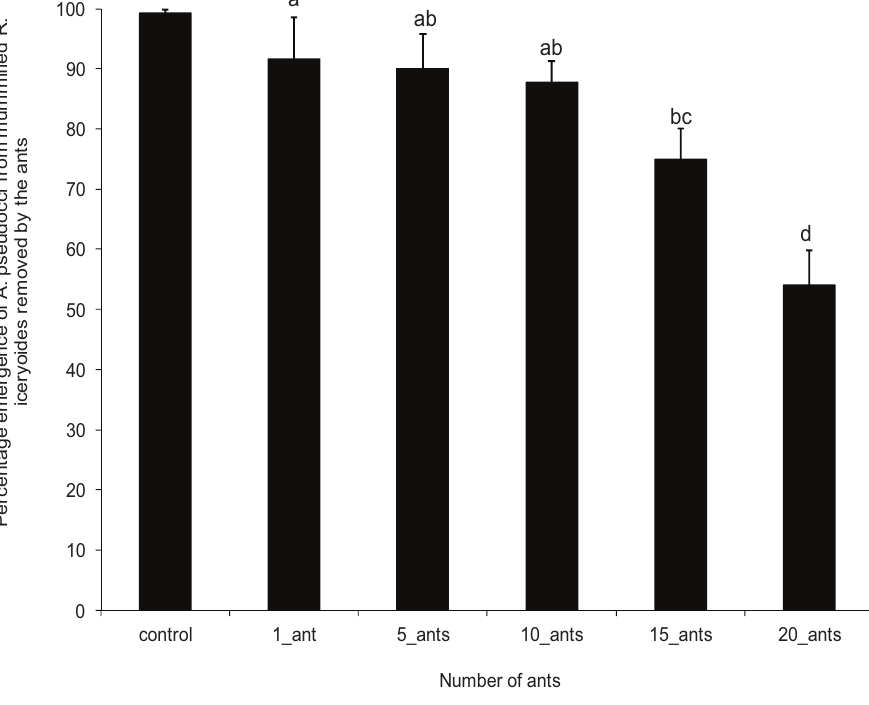
Figure 3. Mean (±standard error) percentage of Anagyrus pseudococci emerged from mummified Rastrococcus iceryoides removed by the different Oecophylla longinoda groups for a period of 2 h. Means with different letters are significantly different at p (cid:2) 0.05.